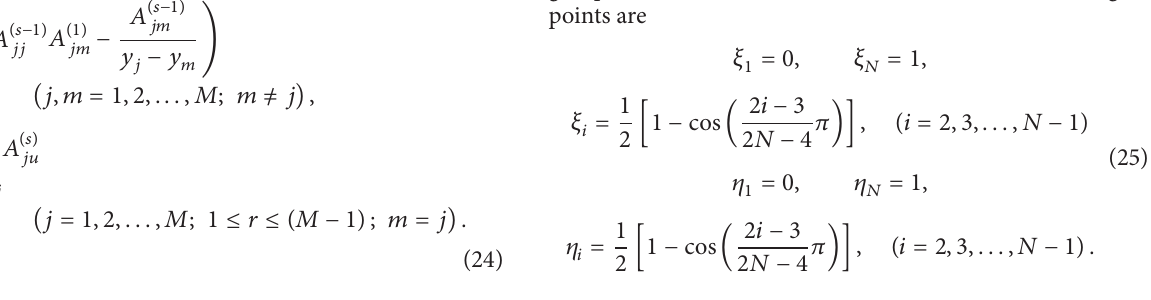
𝐴 (𝑠) 𝑗𝑚 In this paper,